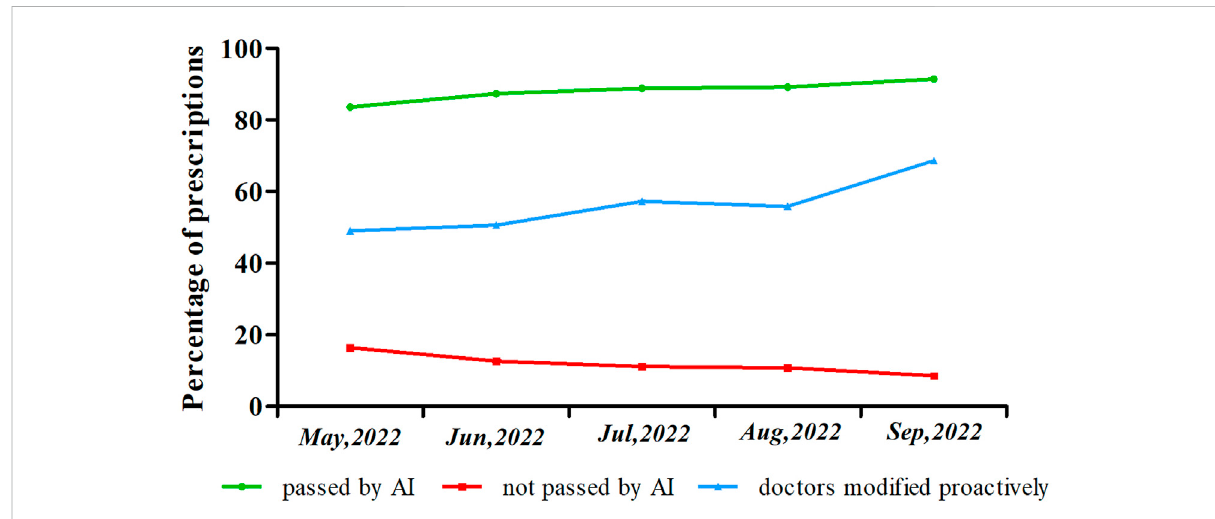
FIGURE 3 Results ofprescriptionspre-reviewedbyAIandmodi fi edbydoctorsproactively. (Greenline:representsthepercentageofprescriptions passed by AI; Blue line: represents the proportion of irrational prescriptions modi fi ed by doctors proactively; Red line: represents the percentage of prescriptions intercepted by AI).